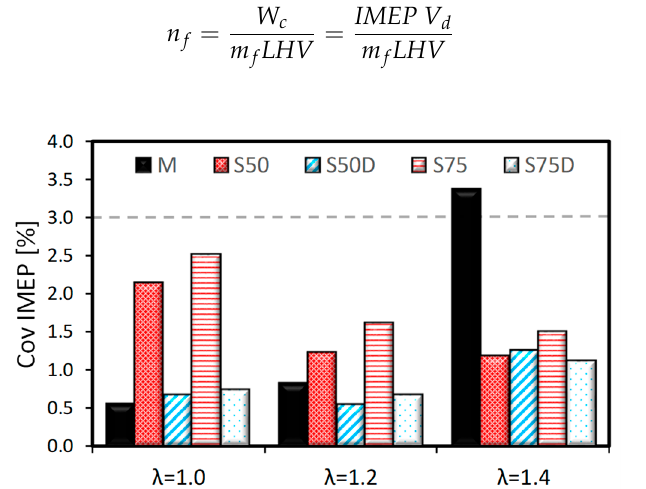
Figure 7. Indicated mean effective pressure for M, S50, S50D, and S75D at fixed SA ( − 7 CAD ATDC) and air-fuel dilution from 1.0 to 1.4.